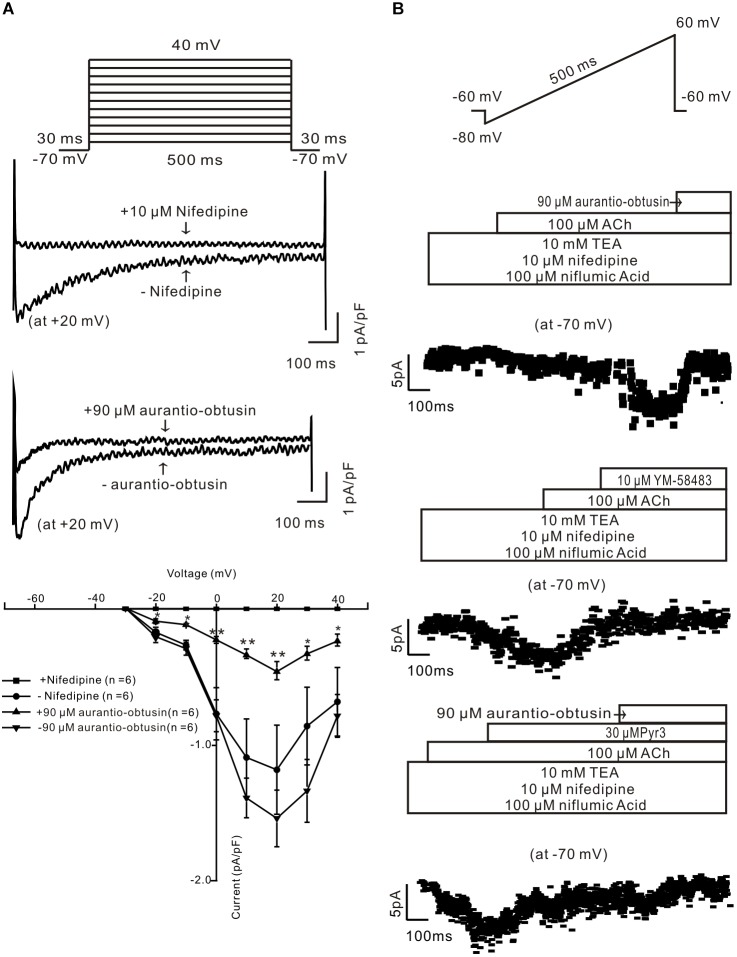
Aurantio-obtusin inhibits ion channel-mediated currents in single tracheal smooth muscle cells. (A) LVDCC-mediated currents were recorded using the voltage steps (top). The representative traces show that the currents are blocked by nifedipine and aurantio-obtusin (middle). The current-voltage curves were plotted (bottom), showing that the currents were completely blocked by nifedipine and markedly inhibited by aurantio-obtusin. ∗P < 0.05; ∗∗∗P < 0.0001. (B) ACh-induced currents were recorded using a ramp (top). The non-selective cation channel (NSCC)-mediated currents are isolated in the presence of three blockers. The currents at -70 mV were used to construct time-current traces, showing that aurantio-obtusin and YM-58483 completely and Pyr3 greatly inhibited the currents. These results suggest that aurantio-obtusin inhibits nifedipine-, YM-58483- and Pyr3-senstive ion channels.